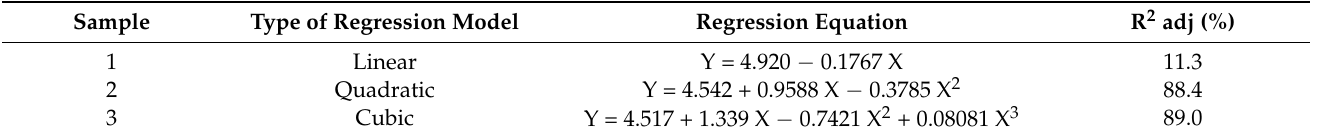
Table 10. The orthogonal polynomial regression model for the mortar flexural strength with the addition of 3% OPS-activated charcoal and EFB hydrochar.